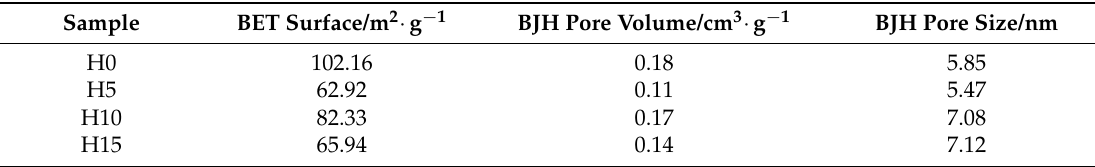
Table 2. BET surface area and pore size of Bi 2 WO 6 samples prepared by different HNO 3 concentrations.